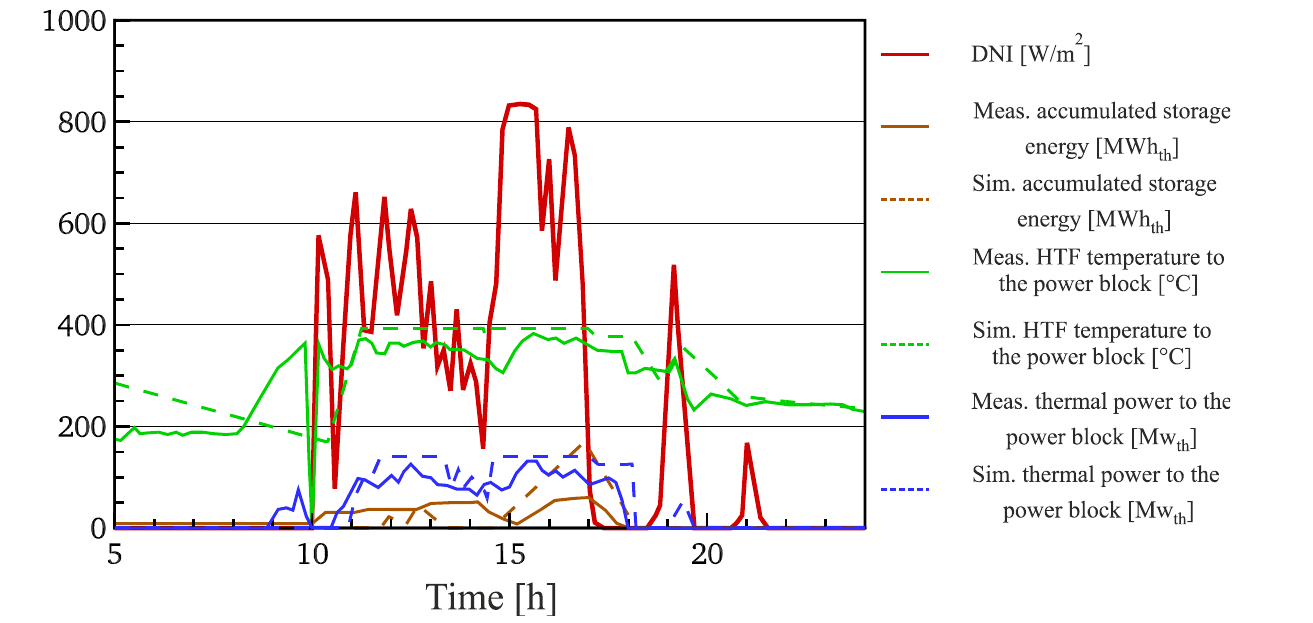
Figure 5. Comparison of simulations and measurements on 2 July 2010.